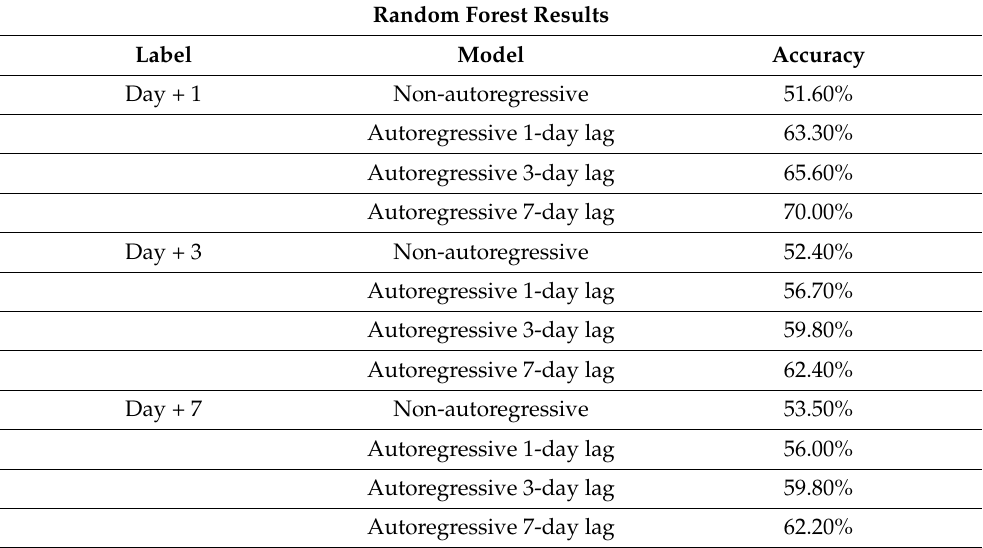
Table 3. Random forest classifier accuracy